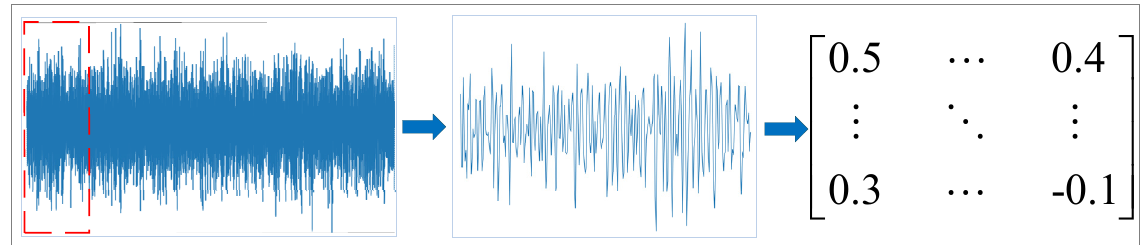
Figure 2. Flowchart of features extraction.